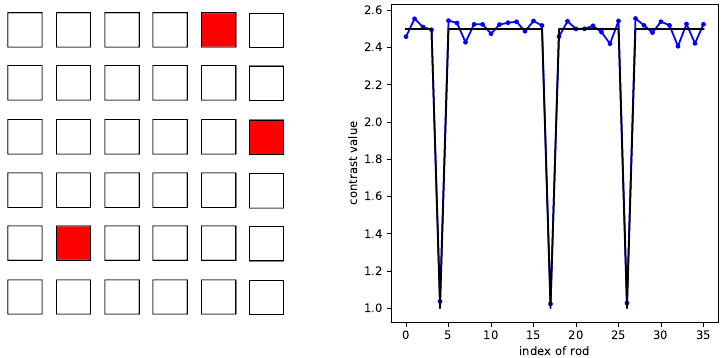
Figure 15. CRNN retrieval for the square shaped rod distribution (the black line represents the ground truth, the blue line the CRNN